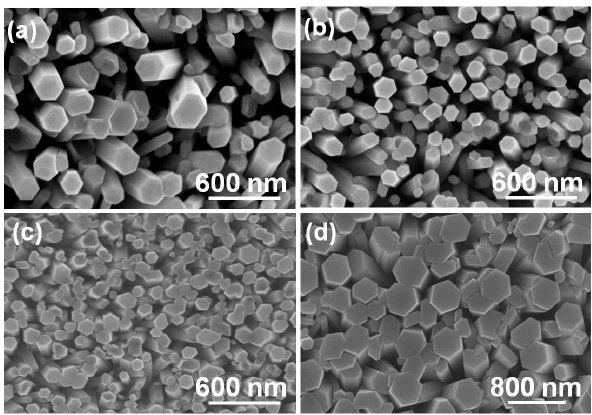
Figure 3. Surface morphologies of hydrothermally grown Eu 3+ -doped ZnO. ( a ) ZnO-10-Eu synthesized at 90 ◦ C, ( b ) ZnO-20-Eu nanowires synthesized at 80 ◦ C, ( c ) ZnO-30-Eu nanowires synthesized at 70 ◦ C, and ( d ) ZnO-40-Eu nanowires synthesized at 60 ◦ C.